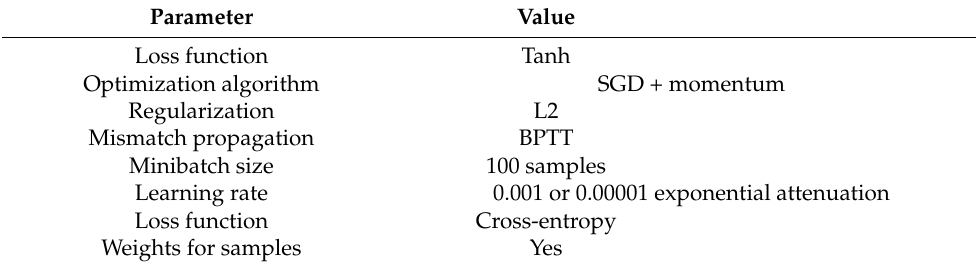
Table 2. Parameters of